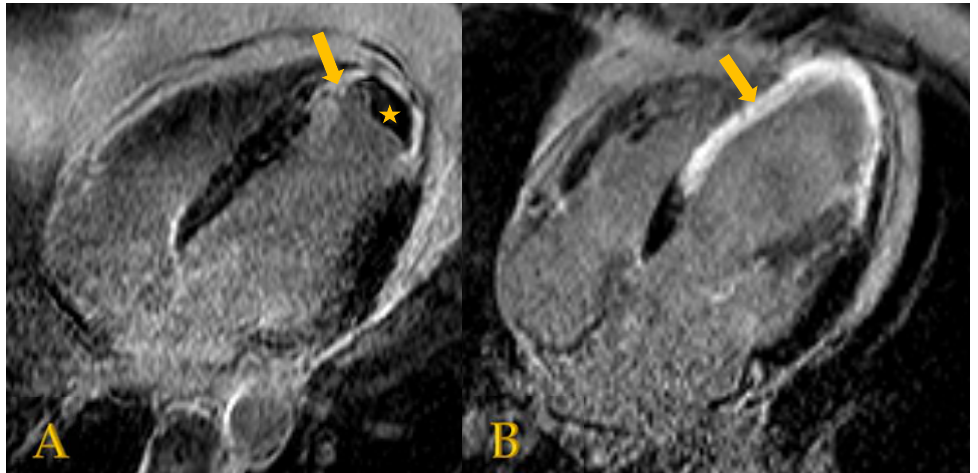
Figure 3. ( A ) CMR image showing a thrombus (asterisk) located in the apical left ventricular aneurysm in a patient with status after transmural infarction. Subendocardial late enhancement (arrow) is seen in the basal wall, lateral wall, and mid-portion of the septum. ( B ) CMR image showing transmural delayed enhancement extending from the basal to apical anteroseptal wall (arrow) in a patient with status after large transmural infarction of the anterolateral wall.